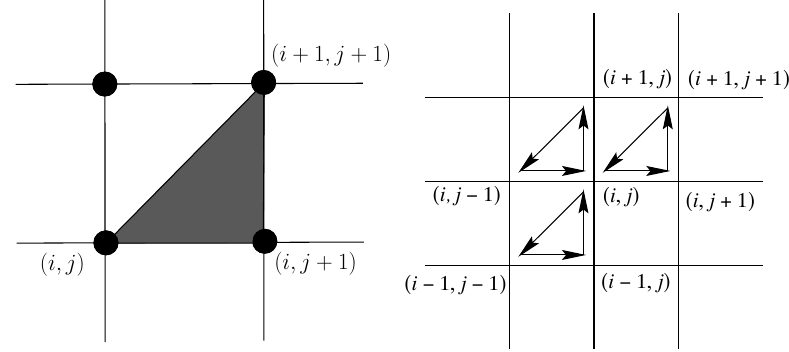
Fig. 5.2. The triangles which touch ( i,j ) Figure 1. Illustration of spacetime discretisation: triangles at spacetime